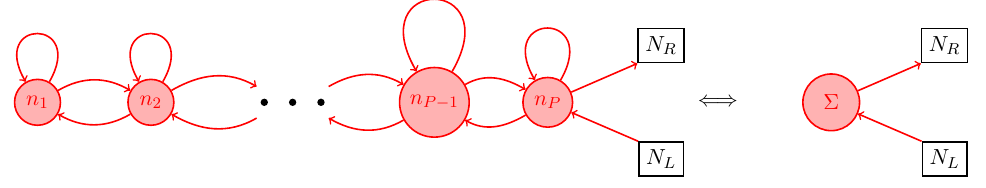
Figure 4 . The general form of (2,2) SQM which realizes a vortex defect in a 3d N = 4 theory.